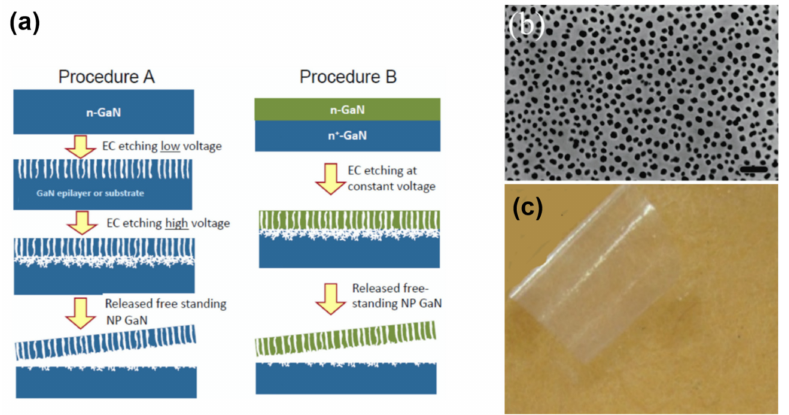
Figure 5. ( a ) Sketches of two different EC etching procedures, ( b ) SEM image of the porous structures formed by EC etching, and ( c ) the GaN membrane released from the porous GaN layer formed by EC etching. NP GaN in (a) stands for the nanoporous GaN. Adapted with permission from [66]. Copyright IOP Publishing,